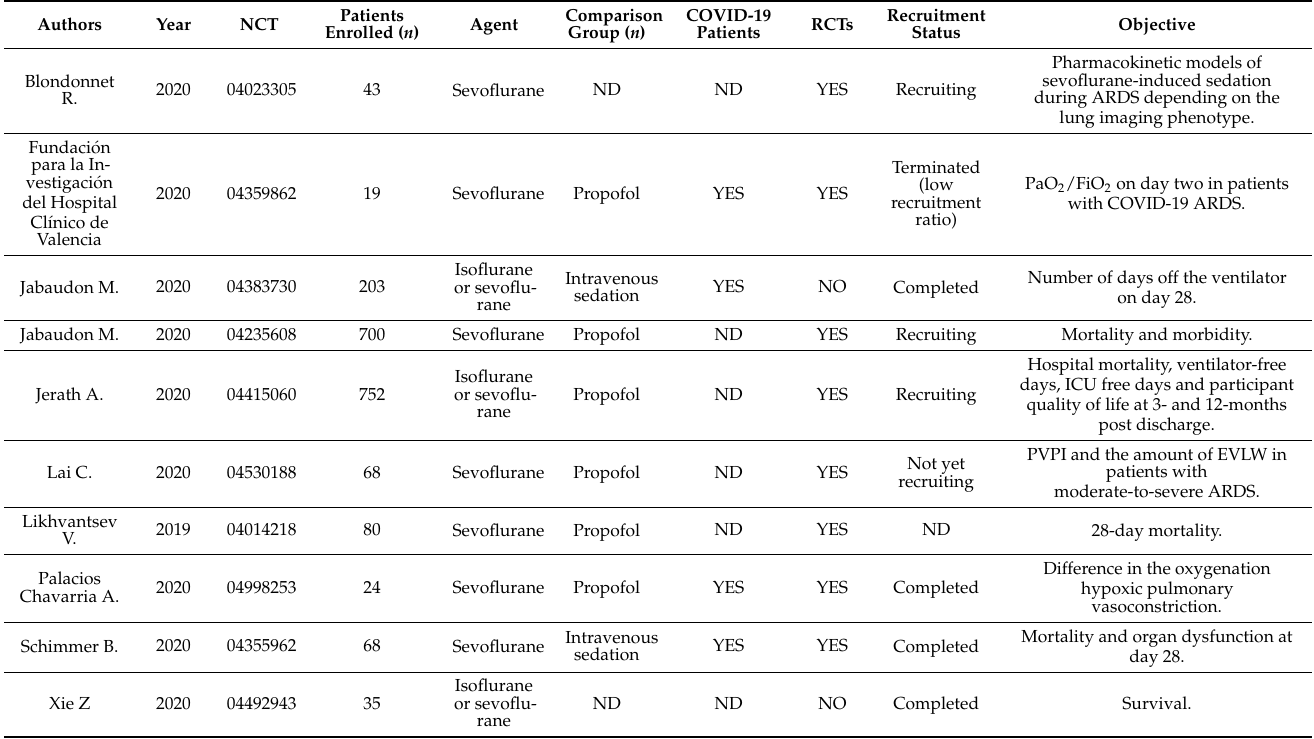
Table 2. Ongoing clinical trials on the use of halogenated anesthetics in ICU patients with ARDS secondary or not to